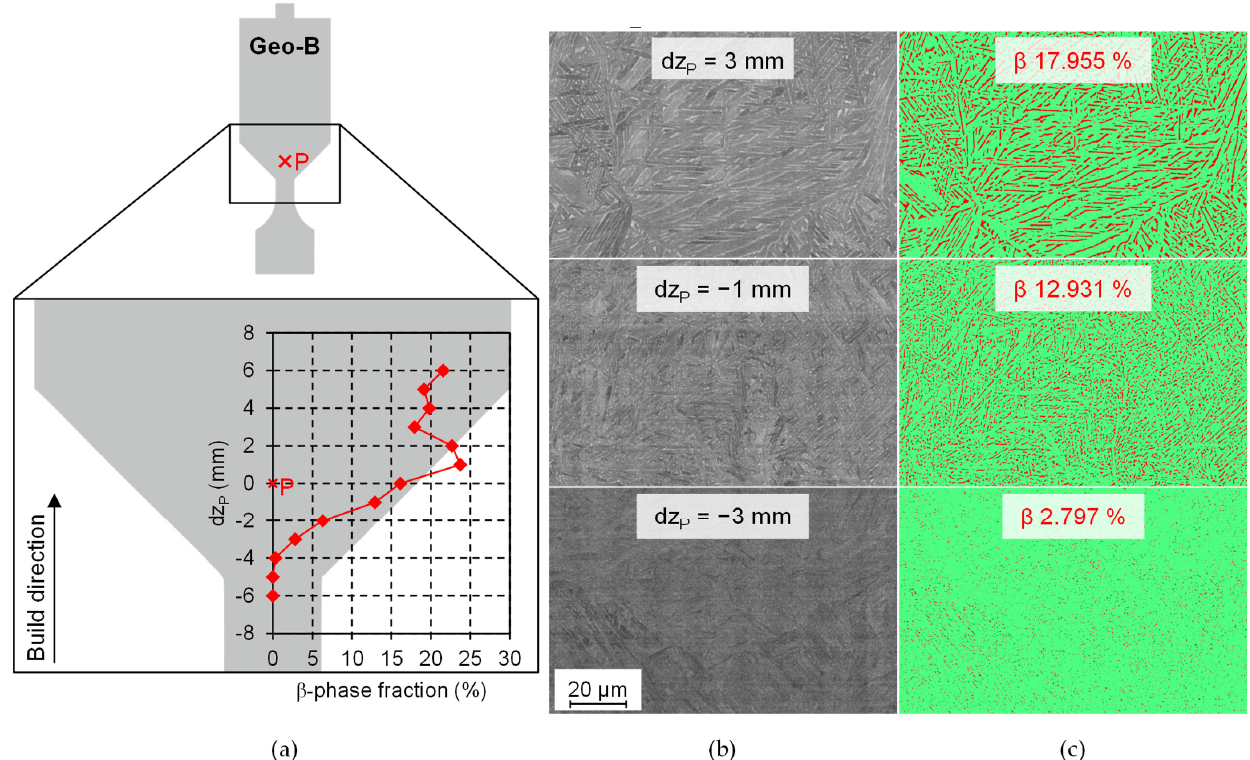
Figure 7. Geometry effect on microstructure for geometry variant Geo-B, ( a ) β phase fraction as a function of distance to point P in build-up direction dz p , ( b ) SEM BSE images at dz P − 3, − 1 and 3 mm, ( c ) α (green)/ β (red) phase fractions separated by Weka segmentation